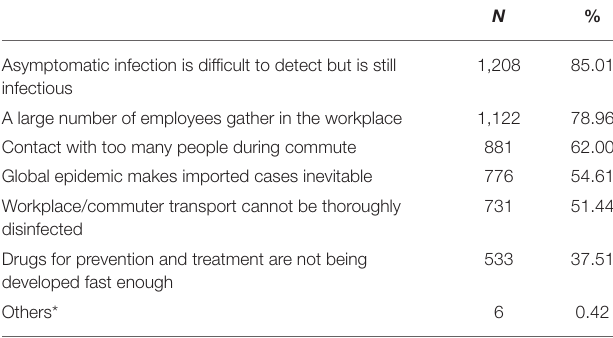
TABLE 2 | Characteristics and associations with concerns about resuming